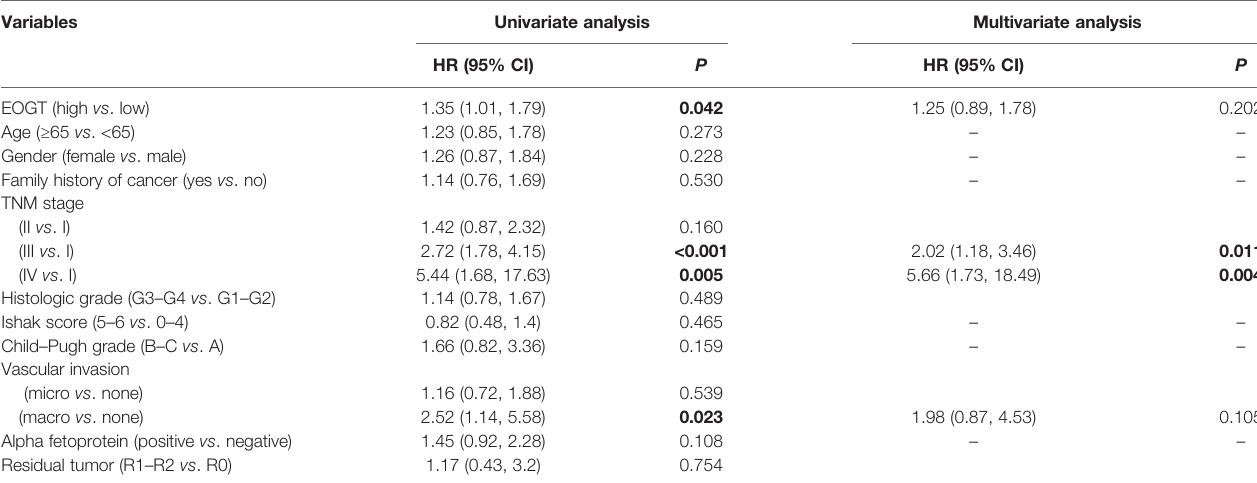
TABLE 1 | Cox proportional hazards regression model analysis of OS. Variables Univariate